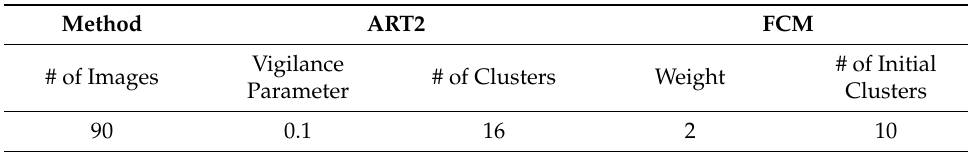
Table 2. Experiment Parameters.